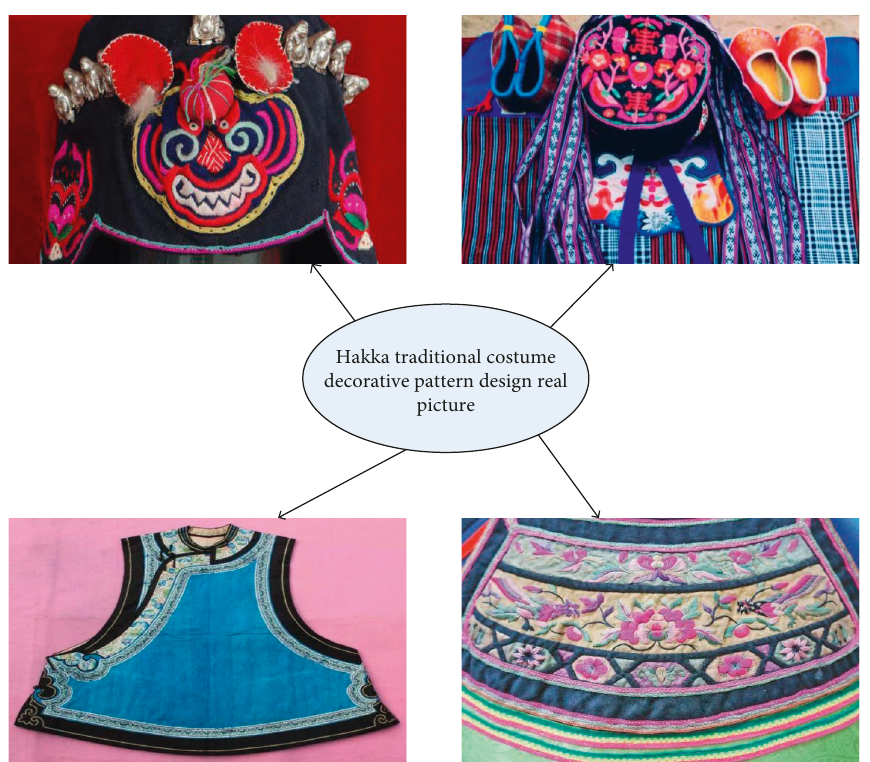
Figure 2: Real picture of decorative pattern design of Hakka traditional